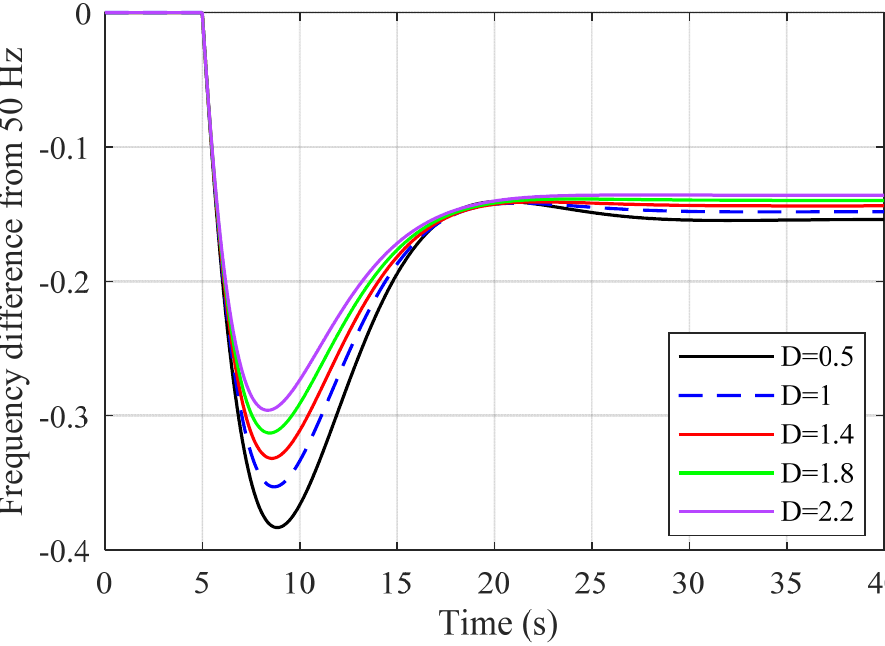
Figure A4. The primary frequency response of GB power system with various values of D.